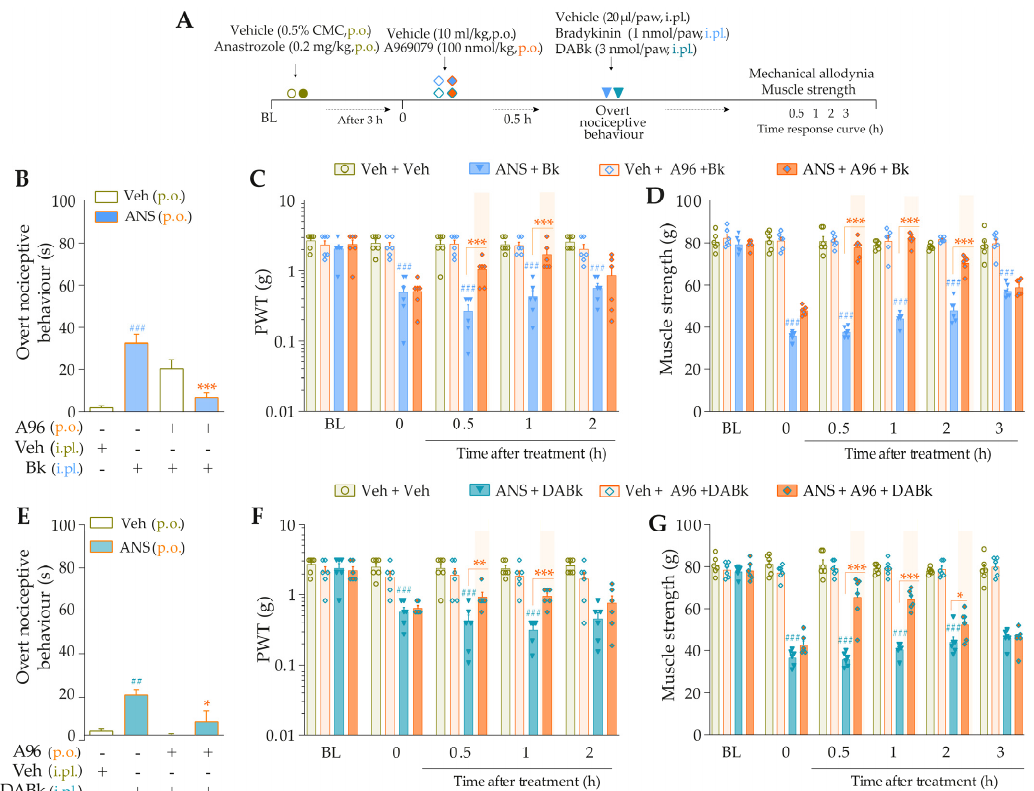
Figure 4. TRPA1 channel contributes to the nociceptive behaviors induced by B 2 R and B 1 R agonists in anastrozole-treated mice. ( A ) Male C57BL/6 mice were treated by the oral route (p.o.) with anas- trozole (0.2 mg/kg) or its vehicle (0.5% CMC) to induce painful behaviors. At 3 h after anastrozole administration (Time 0), the animals received a single administration of vehicle (10 mL/kg, p.o.) or A967079 (100 mg/kg, p.o.). After 0.5 h, vehicle (20 µL/paw, intraplantar, i.pl.) or sub-nociceptive doses of agonists, Bk (1 nmol/paw, i.pl.) or DABk (3 nmol/paw, i.pl.), were injected by the intraplan- tar route. The overt nociceptive behavior was immediately evaluated for 10 min ( B , E ); the PWT ( C , F ) and strength muscle ( D , G ) were assessed until treatments with the antagonist showed an e ff ect. Baseline (BL) values were measured before the anastrozole or vehicle administration. ## p < 0.01 and ### p < 0.001 vs. Veh plus Veh group. * p < 0.05, ** p < 0.01, and *** p < 0.001 vs. ANS plus Bk/DABk group. Data were expressed as the mean + SEM (n = 6/group) and analyzed by one- or two-way ANOVA followed by the Bonferroni post hoc test. Veh: intraplantar, intraperitoneal, or oral vehicle injections; ANS: oral administration of anastrozole; Bk: bradykinin intraplantar treatment; A96: A967079 oral treatment; PWT: paw withdrawal threshold.